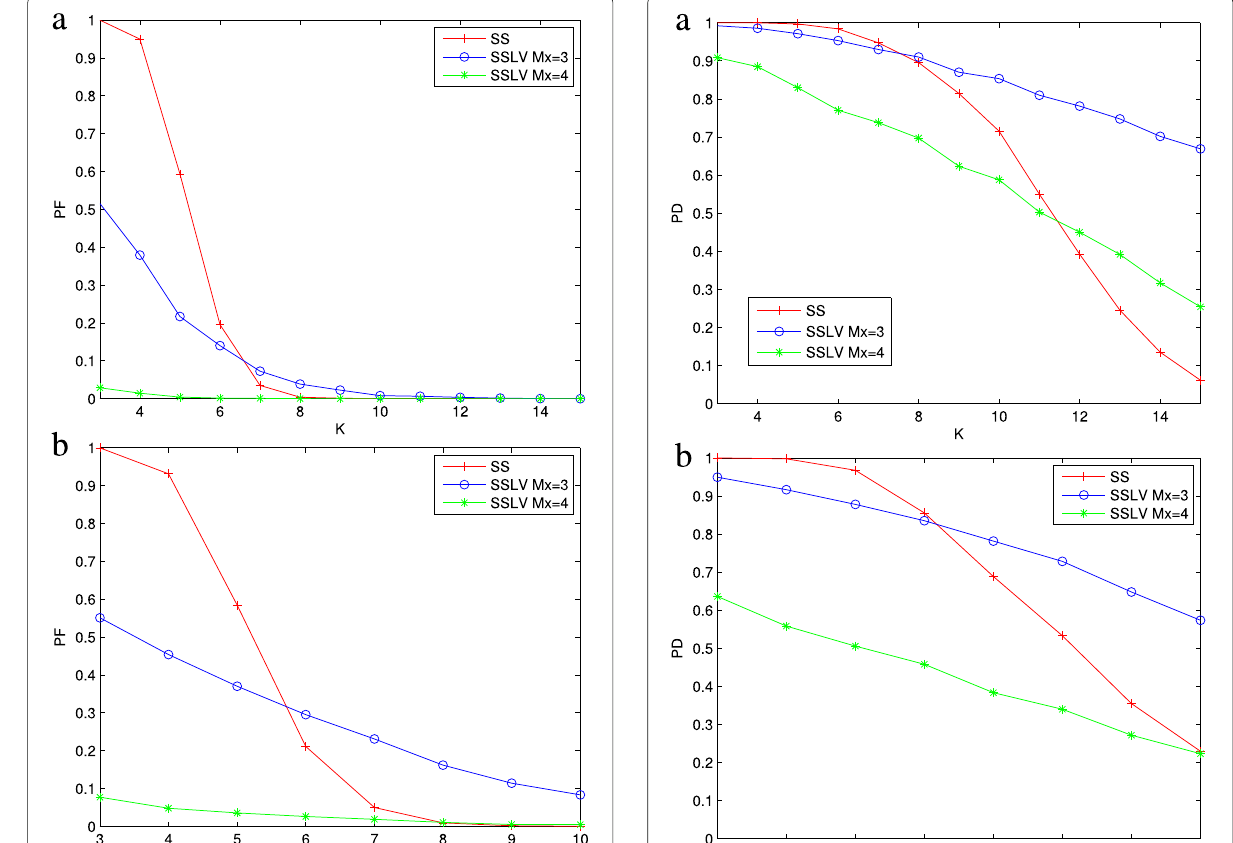
grid, and M i = 9. In Fig. 4b, sensors are randomly